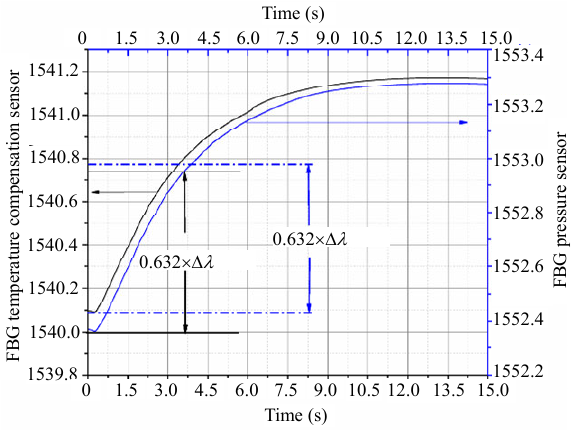
Fig. 3 FBG pressure and temperature compensation sensors’ response time comparison diagram.